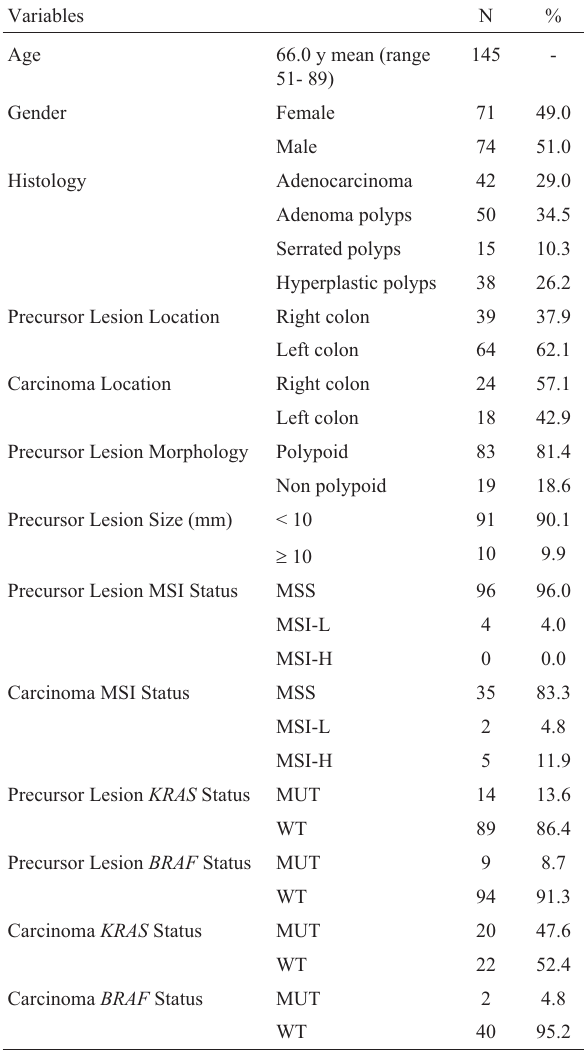
Table 1 - Clinicopathological and molecular features of all